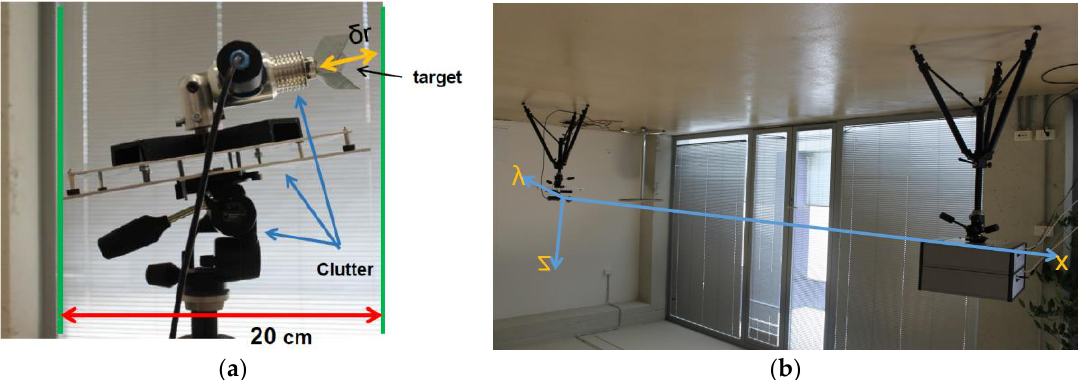
Figure 10. Estimation of 2D vibrations by closely spaced Radar. ( a ) Trihedral target mounted on a tripod with precise setting of angles and position: The sources of clutter in the 20 cm resolution cell are shown. ( b ) Set-up of the experiment showing the target and the two Radars, stacked one upon the other.